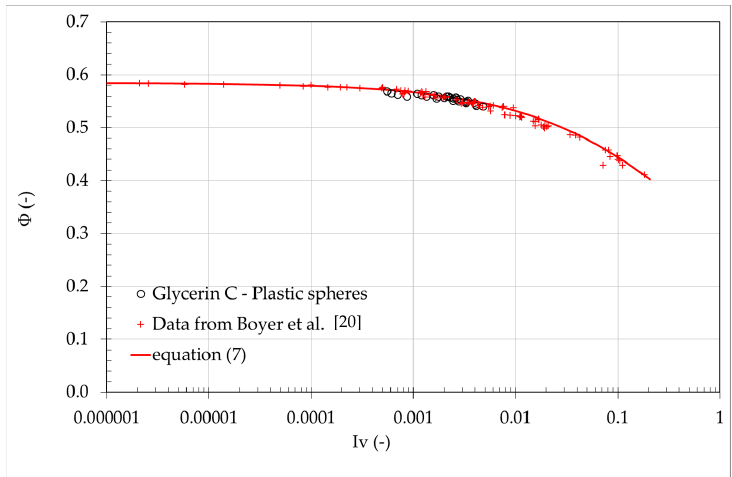
Figure 9. Plastic sphere–glycerin solution: relation between the volume fraction Φ and the viscous number I v compared with data reported by Boyer et al. [20], plotted in a semi logarithmic chart to appreciate the value of the maximum solid concentration during shearing. Solid line: theoretical curve from Equation (7).